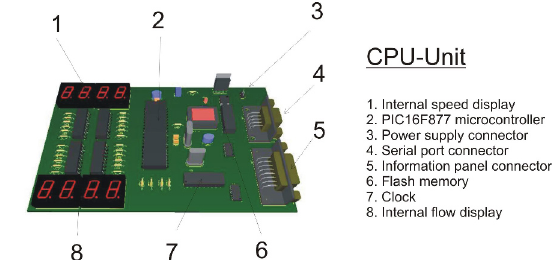
Figure 5. CPU-Unit design version